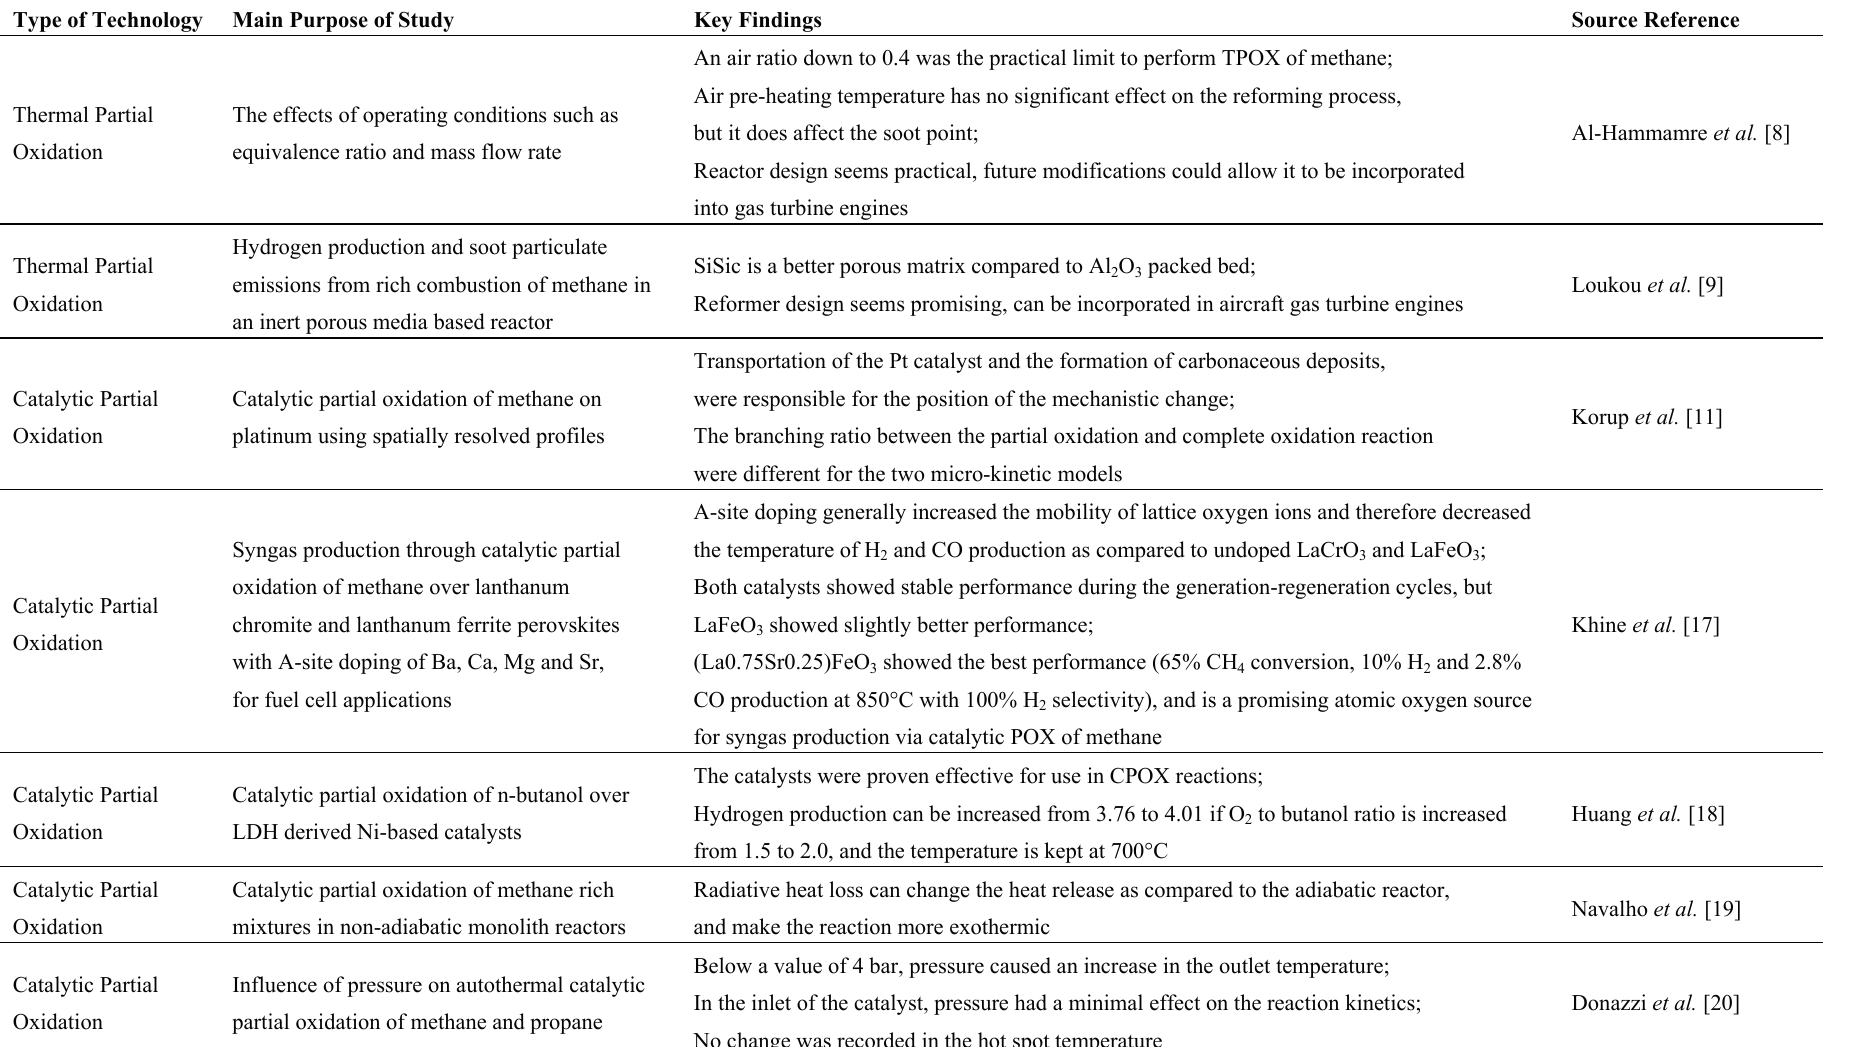
Table 5. Summary of Technology